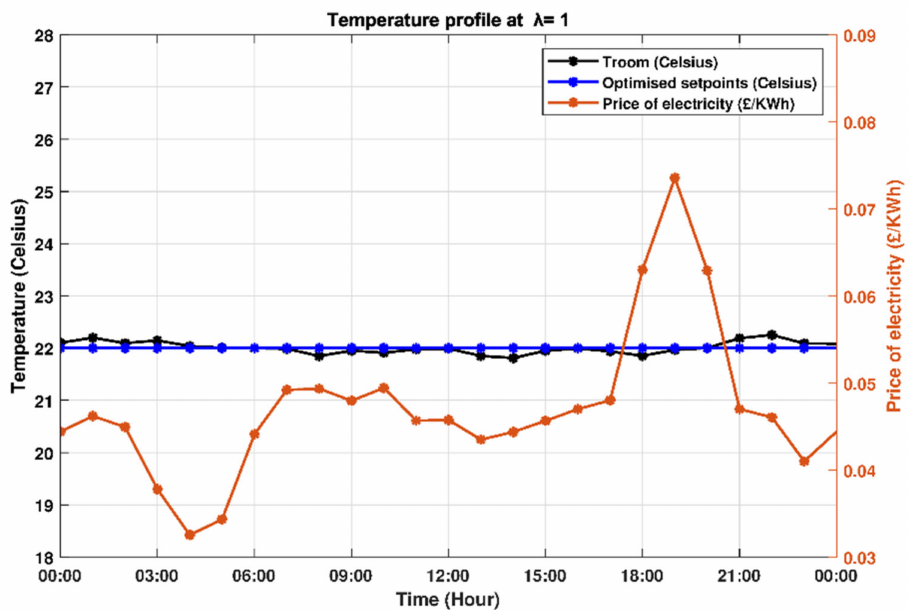
Figure 8. Room temperature and MPC-generated setpoints over 24 h when λ is set to 1—indicating maximum preference for thermal comfort.